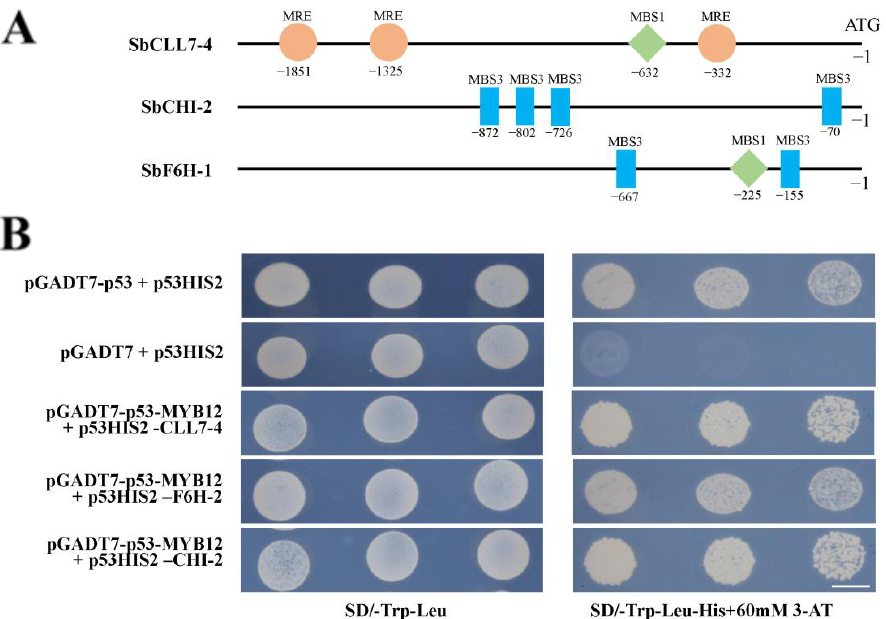
Figure 8. SbMYB12 binds to the SbCCL7-4 , SbCHI-2 , and SbF6H-1 promoters. ( A ) Distribution of the MYB-binding sites in the SbCCL7-4 , SbCHI-2 , and SbF6H-1 promoters. ( B ) Y1H assays indicated in- teractions between SbMYB12 and the promoter regions of SbCCL7-4 , SbCHI-2 , and SbF6H-1 . MRE: AACCTAA; MBS1: CAACTG; MBS3: TAACTG. (Scale bar: 6 mm). AACCTAA; MBS1: CAACTG; MBS3: TAACTG. (Scale bar: 6